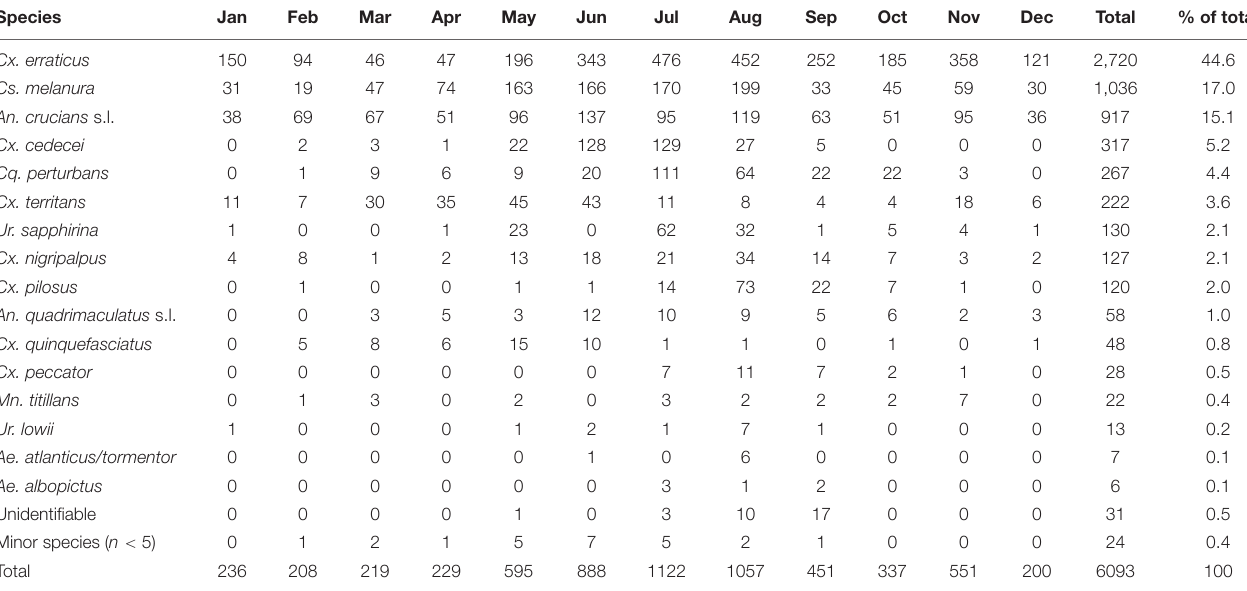
TABLE 2 | Monthly numbers of Cs. melanura and other mosquito species. Mosquitoes were collected using resting shelters in Orange and Polk County, FL, in